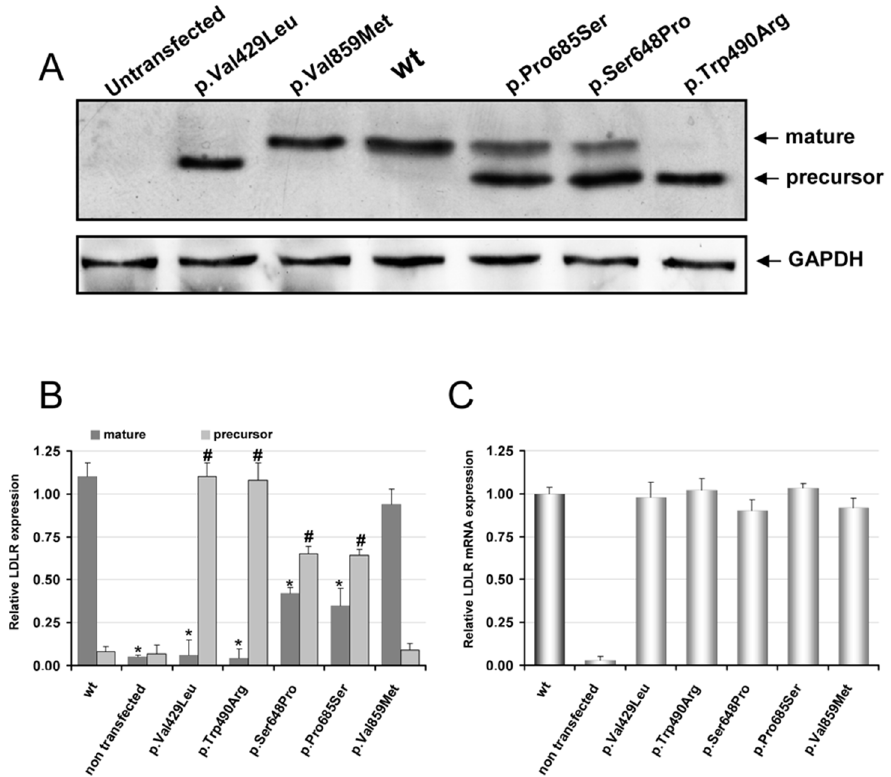
Figure 1. Protein and mRNA expression of wt LDLR and LDLR variants in CHO- ldlA7 transfected cells. Cells were transfected with the corresponding plasmids carrying the mutations of interest, LDLR was overexpressed for 48 h and then (A) protein expression was analyzed by Western blot, (B) the relative band intensities of both mature and precursor LDLR forms were calculated as the ratio of 160 kDa or 130 kDa LDLR band intensity to that of GAPDH (C) relative LDLR mRNA expression determined by qRT-PCR (normalised to GAPDH). A representative experiment from three independently performed assays is shown in (A). The values in (B) and (C) represent the mean of triplicate determinations (n=3) and (n=2), respectively; error bars represent 6 SD. Levels of significance were determined by a two-tailed Student’s t-test, and a confidence level of greater than 95% (p , 0.05) was used to establish statistical significance. *p , 0.001 compared to the LDLR wt 160 kDa band and # p , 0.001 compared to LDLR wt 130 kDa band using a Student’s